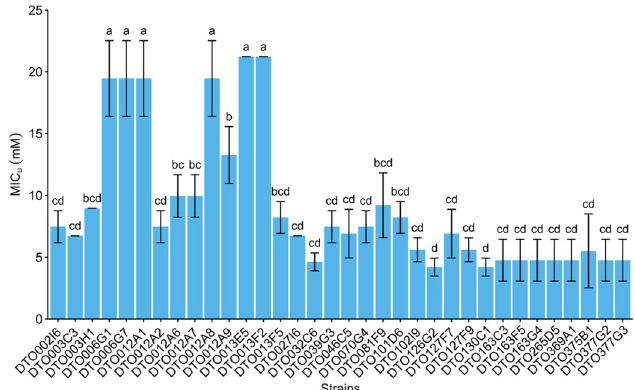
Fig 2. Sorbic acid resistance screening reveals 6 resistant P . roqueforti strains. Average undissociated MIC u values of sorbic acid of 34 P . roqueforti strains (mM ± standard deviation). Each bar graph represents biological triplicates. Error bars indicate standard deviation and letters indicate significant difference in MIC u (p <